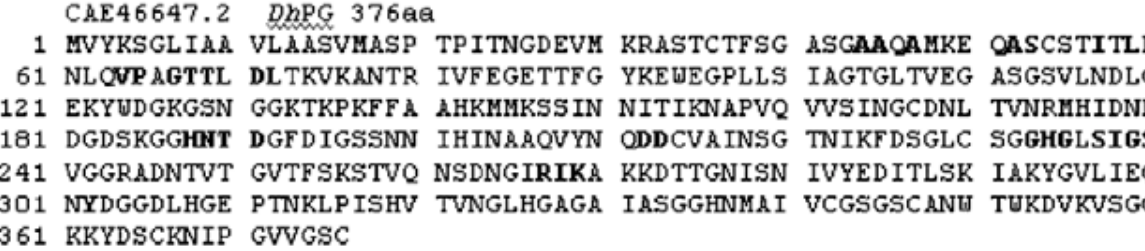
Figure 2a. Aminoacidic sequence of Dh PG predicted protein. Aminoacids with bold font: consensus residues in fungal